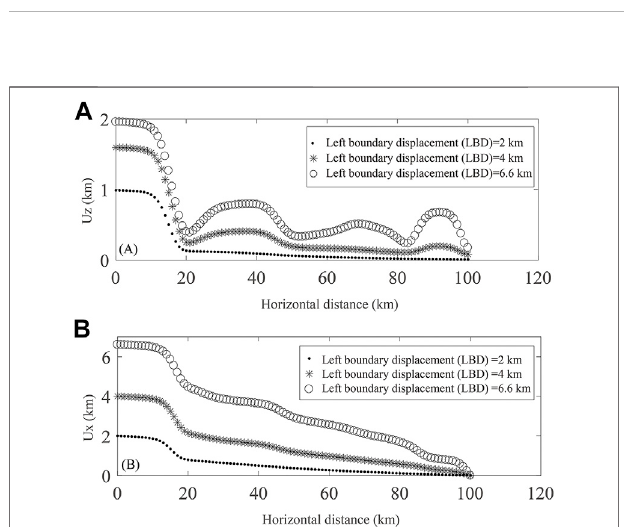
FIGURE 6 | Dynamic surface 2D displacements over pro fi le in Jiudong Basin obtained in Model 1 (reference) after 2, 4, and 6.6 km of left boundary displacement (LBD, here also equating to HS). Using model ’ s initial frame, panels display (A) vertical displacement (Uz) and (B) horizontal displacement (Ux), as functions of horizontal coordinate (in undeformed frame). As can be seen, both vertical and horizontal displacements (as a function of distance and of shortening) are inhomogeneous and nonlinear; thus, they have associated 2D differential deformations and rotations.